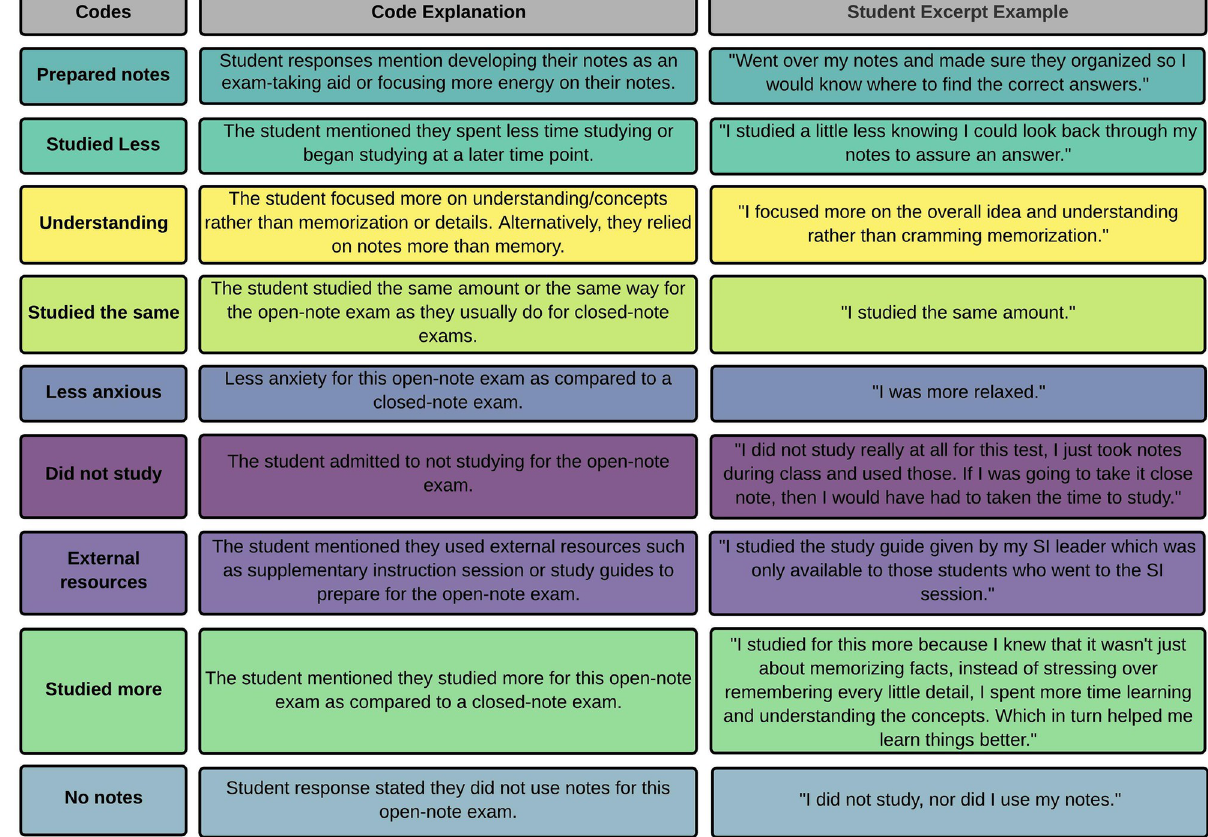
PLOS ONE | https://doi.org/10.1371/journal.pone.0273185 August 18,